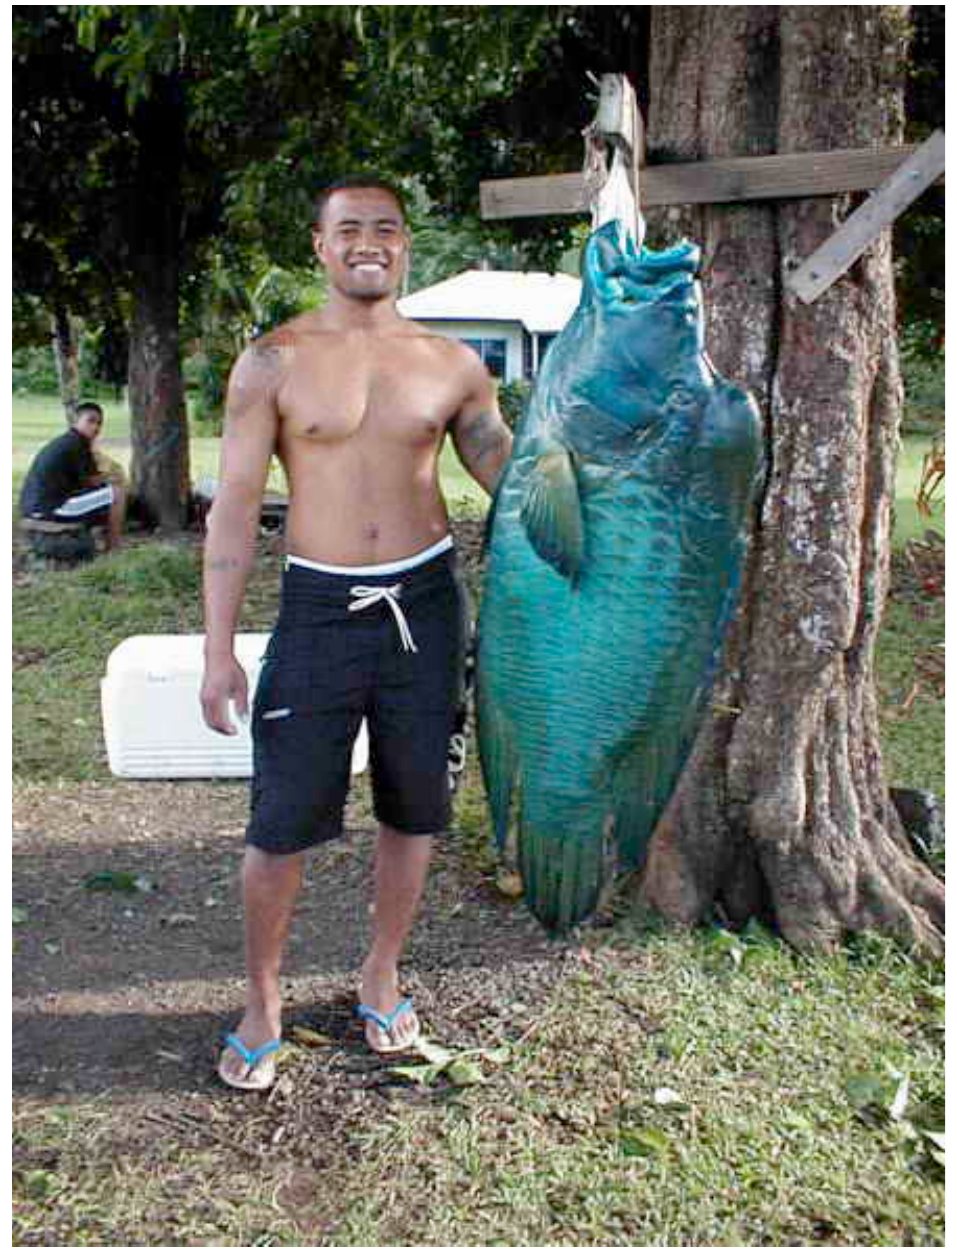
Figure 1. Humphead wrasse ( C. undulatus ) and the fisherman who caught it in American Samoa. This fish sold for $120. A similar fish in Guam would now sell for about $2,000. Photo by Leslie Whaylen,